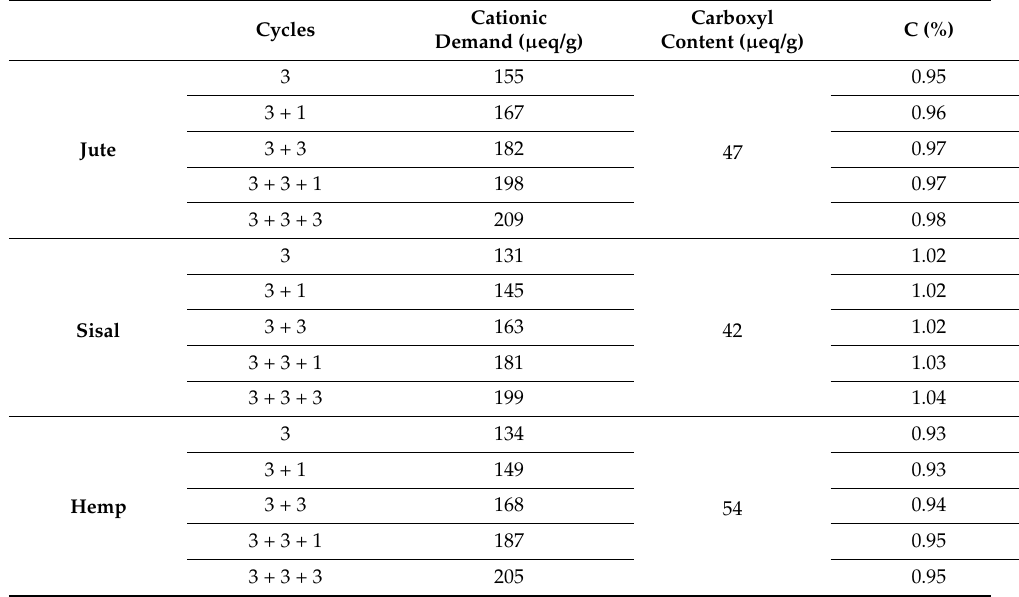
Table A2. Consistency (C), cationic demand and carboxyl content of all mechanical MNFC